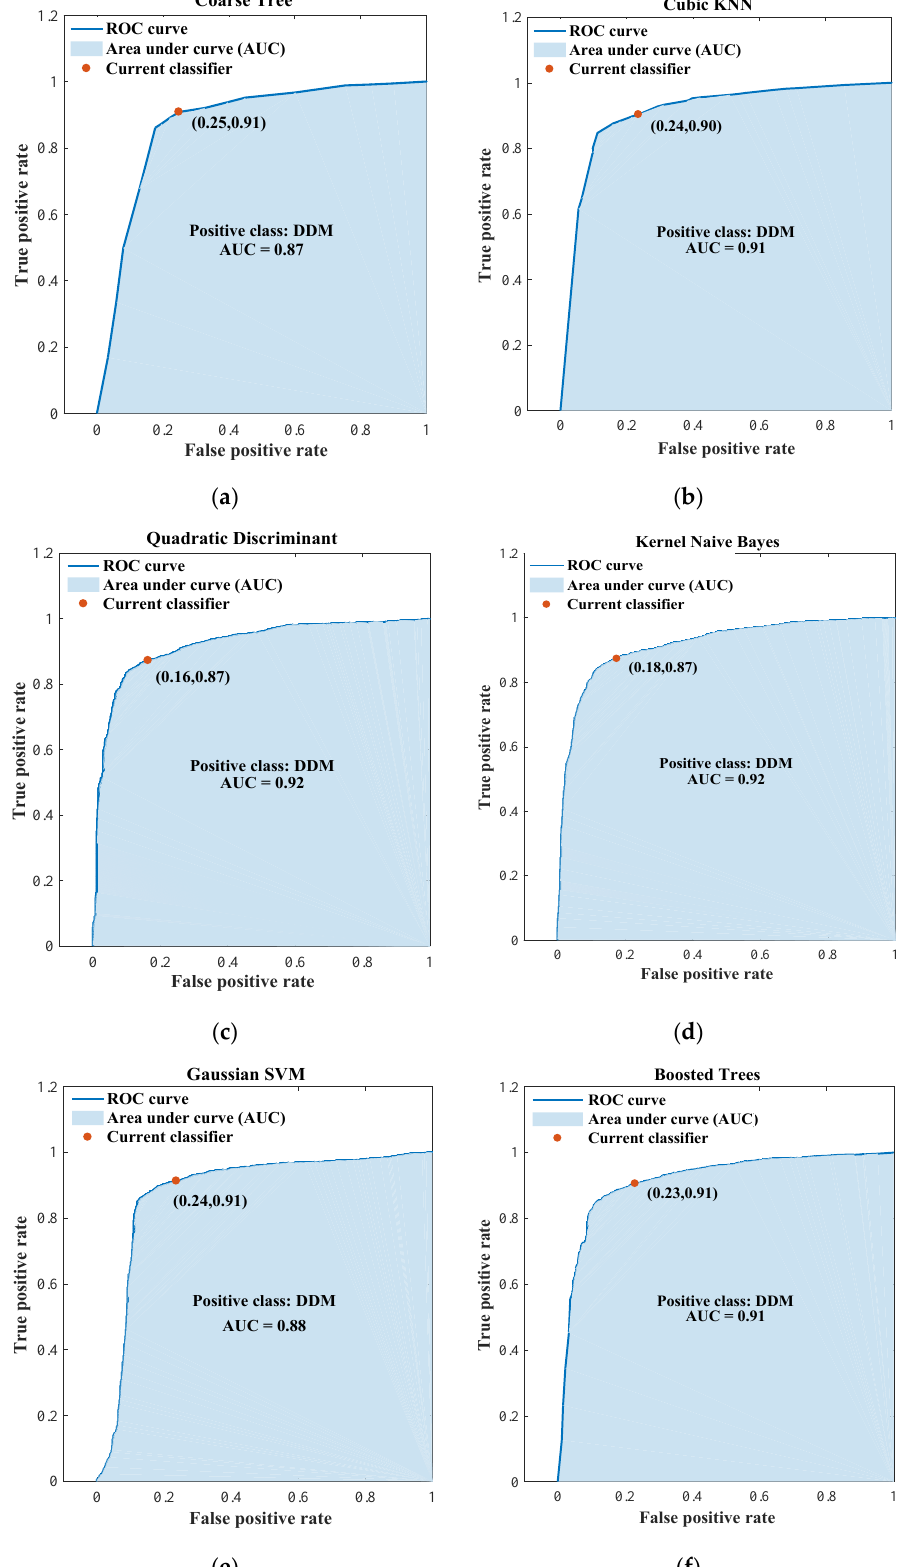
Figure 12. Receiver operating characteristics (ROC) curve for each classification model. ( a ) Coarse Tree; ( b ) Cubic KNN; ( c ) Quadratic Discriminant; ( d ) Kernel Naïve Bayes; ( e ) Gaussian SVM; ( f ) Boosted